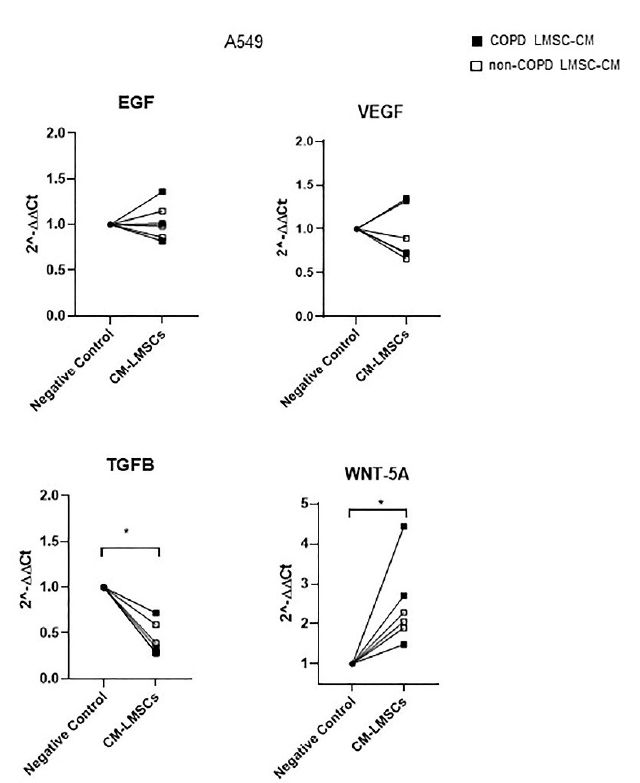
Figure 4. Conditioned medium from lung-resident MSCs (LMSCs) decreases the mRNA expression TGF- β and increases the mRNA expression of WNT-5A in A549 cells after scratch wounding. A549 cells were seeded in duplicates and grown to confluence for 48 h. Medium was refreshed and replaced by control medium or conditioned medium (CM) of LMSCs from 3 non-COPD control and 3 COPD donors. Cells were harvested for RNA isolation after 48 h and expression of EGF , VEGF , TGFB and WNT5A was related to the expression of the housekeeping genes B2M and PPIA and expressed as 2 −ΔΔCt compared to baseline. Data are presented as mean ± SEM. LMSC-CM from non-COPD donors is indicated by open symbols, from COPD donors by closed symbols. * = p < 0.05 between the indicated values as analyzed by the Wilcoxon signed rank test for paired observations.